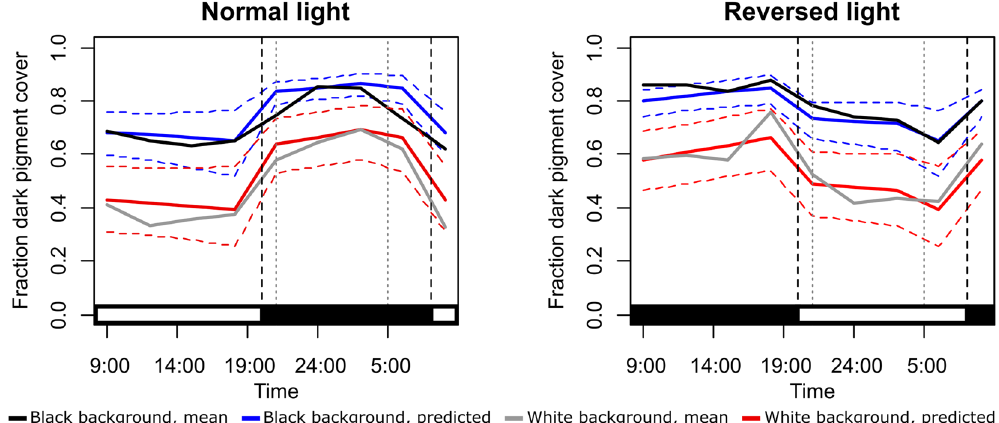
Figure 3. Effect of background colour and light on Crangon crangon mean dark pigment cover over a day-night cycle. The illumination regime is indicated with a black/white bar at the bottom of each graph. Solid lines: mean and predicted values on black and white backgrounds; dashed horizontal lines: confidence interval predictions; black dashed vertical lines: moment of light switch; period between grey dashed vertical lines: no day light. Measurements were made every 3 hours. N = 20 per treatment.